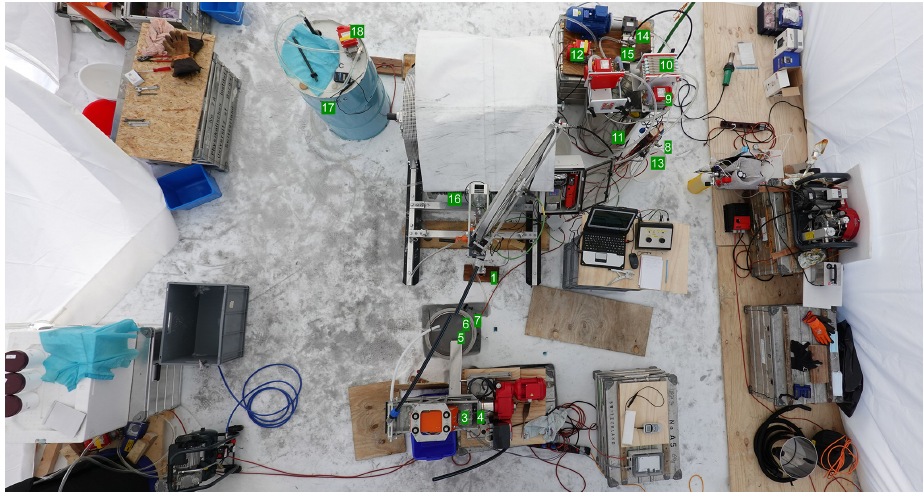
Figure 10. Bird’s-eye view of the RADIX system. Component numbers correspond to the legend in Fig. 8.